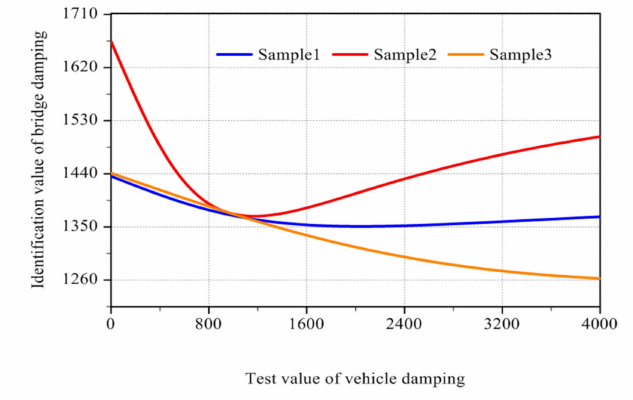
Figure 17. Bridge damping identification curve